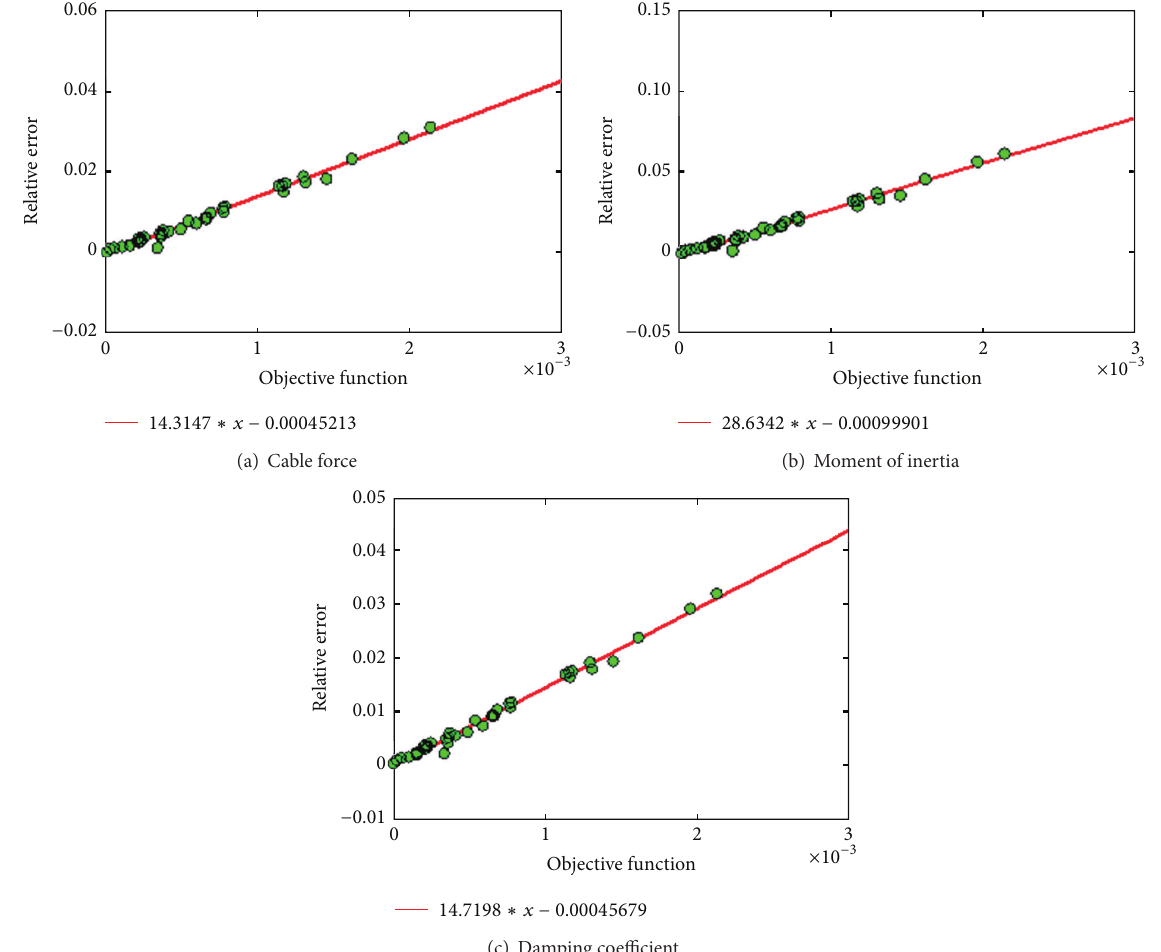
Figure 9: Relationship curves between relative errors of objective function and correction variables.